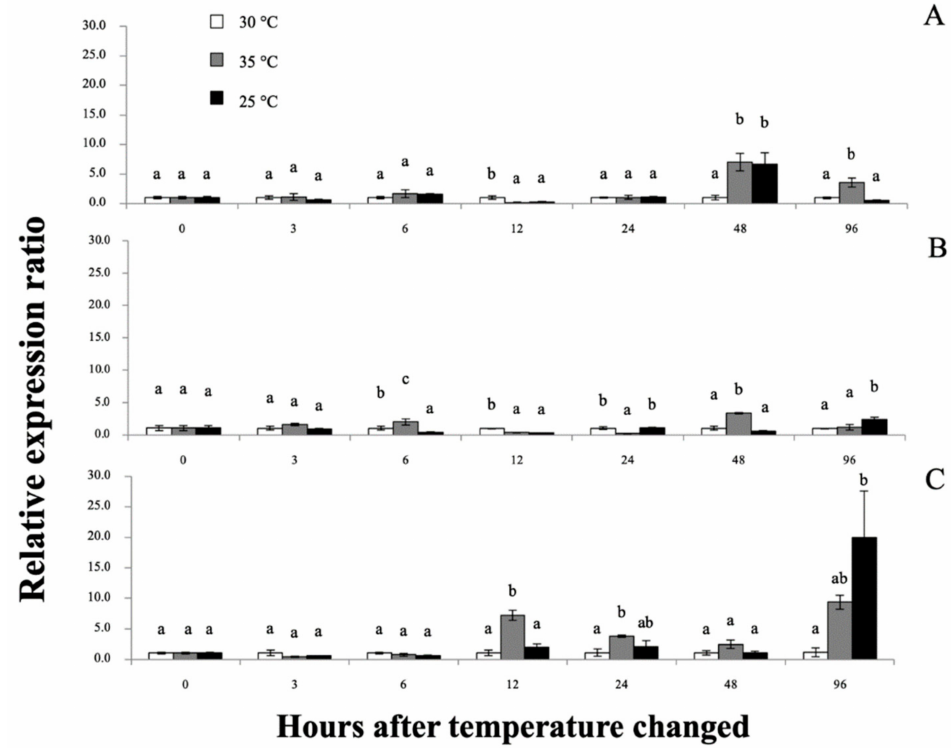
Figure 11. The Mr-hsp40 mRNA expression levels relative to β -actin levels analyzed by qRT-PCR in the gills ( A ), hepatopancreas ( B ) and hemocytes ( C ) of giant river prawns after induction with temperatures at 30, 35 and 25 ◦ C. The values are shown as means and SDs, n = 6. Data with different letters (a, b and c) were significantly different ( p < 0.05) at the same exposure times. Descriptions of this part are also provided for Figure